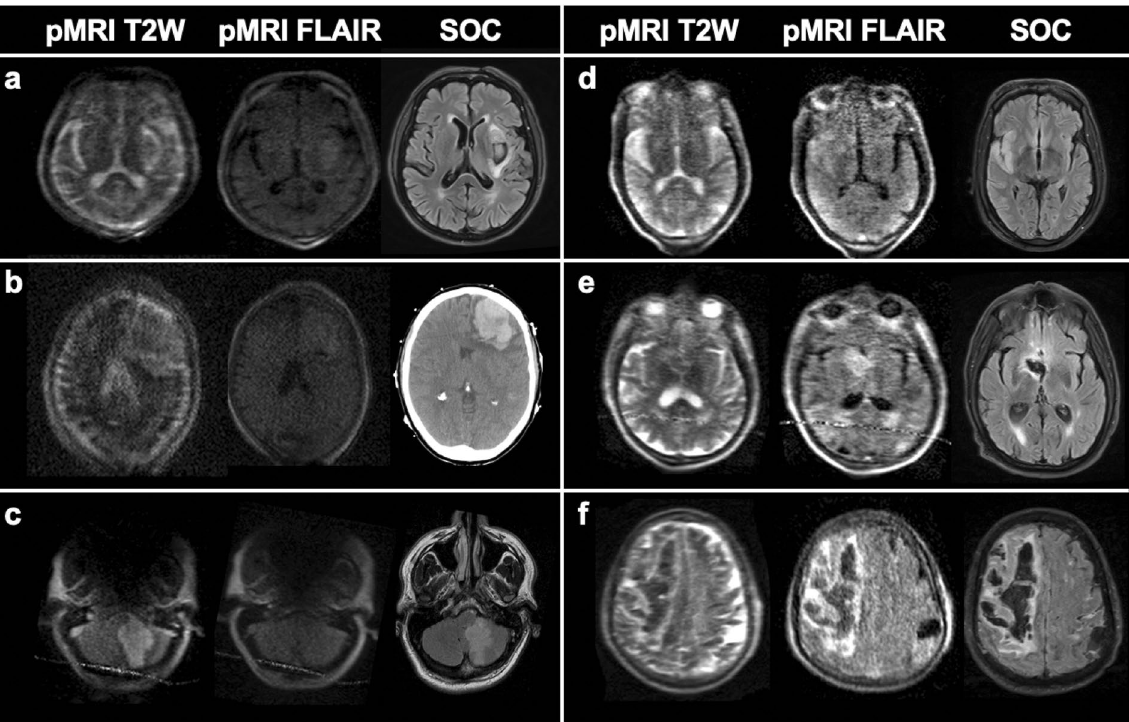
Figure 4. Evolving image quality and continuous development of the portable MRI (pMRI) device. ( a ) 71-year-old male with leftsal ganglia intracerebral hemorrhage; software RC3. ( b ) 71-year-old female with left frontal intracerebral hemorrhage; software RC4. ( c ) 58-year-old male with left cerebellar infarct; software RC5. The pMRI fluid-attenuated inversion recovery (FLAIR) did not capture the lesion. ( d ) 50-year-old male with right middle cerebral artery infarct; software RC6. ( e ) 68-year-old male with rightsal ganglia intracerebral hemorrhage; software RC7. ( f ) 81-year-old male with right frontoparietal intracerebral hemorrhage; software RC8. All SOC MRI exams shown are FLAIR images. T2W indicates T2-weighted; SOC indicates standard-of- care imaging. Figure created using: Microsoft PowerPoint, Version 16.52, https:// www. micro soft. com/ en- us/ micro soft- 365/ power